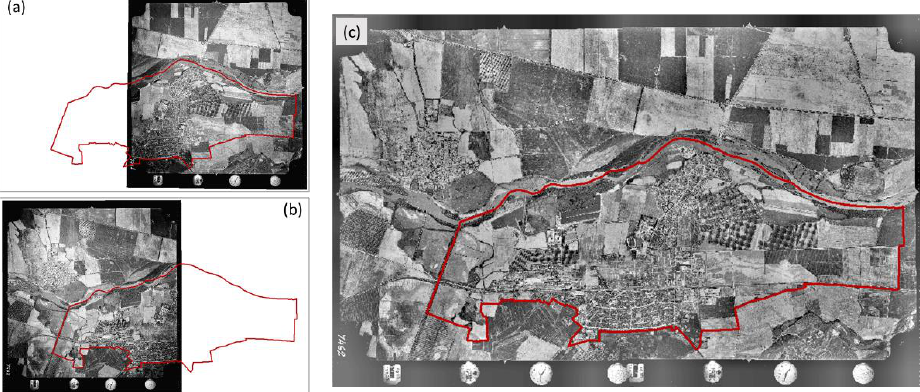
Figure 7. ( a , b ) Aerial photographs from 1975 covering a portion of Stamboliyski and ( c ) mosaicked 1975 aerial photographs. Red vector illustrates the boundaries of the Stamboliyski town.